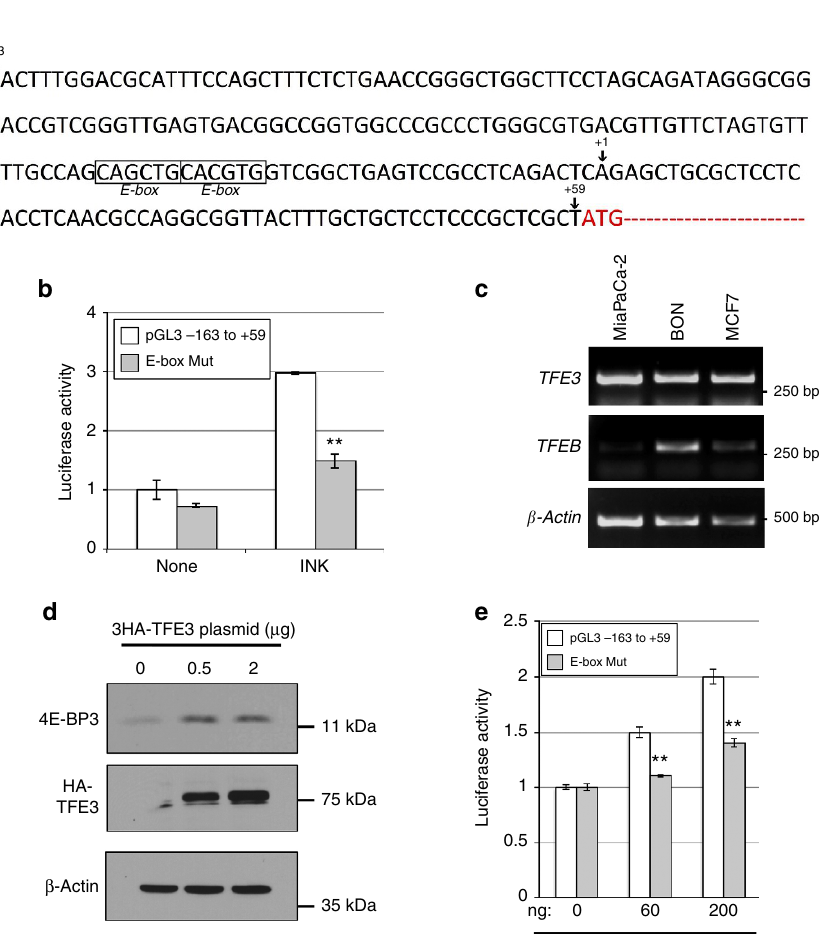
Figure 2 | E-boxes function as cis -elements for the EIF4EBP3 promoter activation by TFE3. ( a ) Sequence ( (cid:2) 163 to þ 59) in the EIF4EBP3 promoter region. Position þ 1 indicates the information of putative transcription start site (the DBTSS (http://dbtss.hgc.jp)). Protein coding region is shown by red characters. ( b ) E-box mutation reduces EIF4EBP3 promoter activity. E-box sequences 5 0 -CAGCTG CACGTG-3 0 were changed to 5 0 -GTCCTG GTGGTG-3 0 . MiaPaCa-2 cells were transiently transfected with p4E-BP3pro-Luc ( (cid:2) 163 to þ 59) plasmid or its E-boxes mutant and pRL-TK reporter plasmid as a control. After 24h, cells were treated with 100nM of INK1341 for 24h. Relative luciferase activity was measured using Dual-Luciferase Assay kit. Error